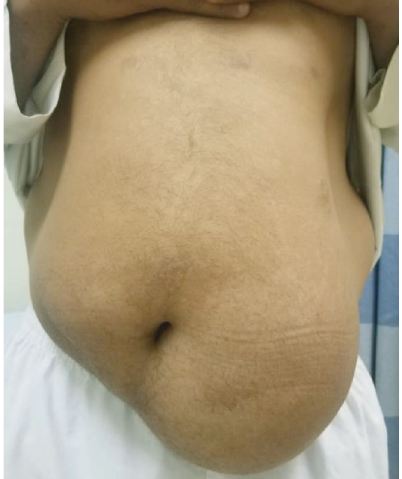
Figure 1: The patient (frontal view) before surgery.